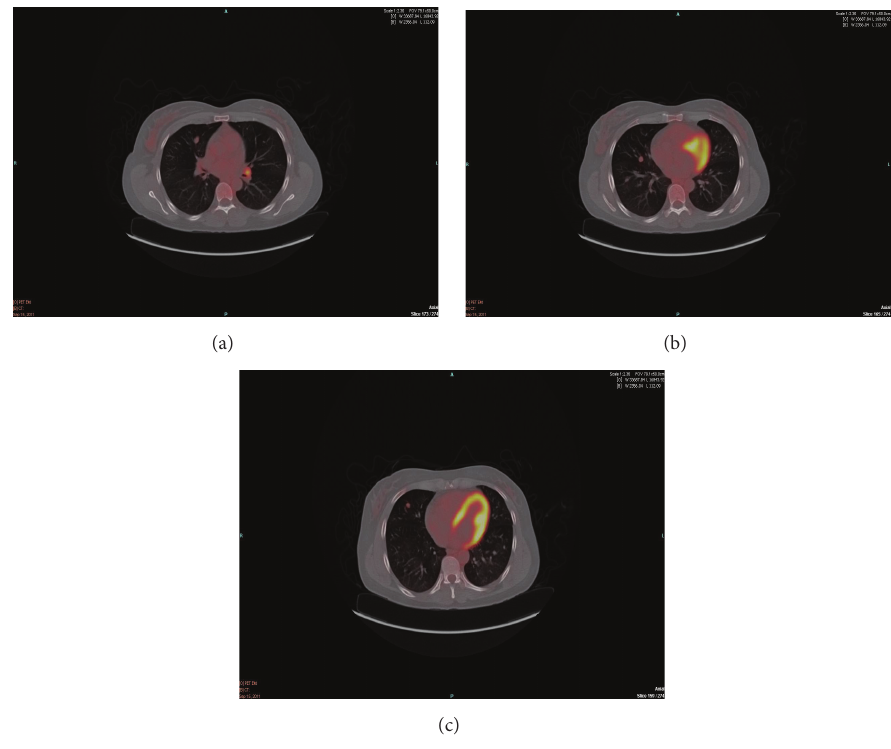
Figure 4: Multidisciplinary review of PET